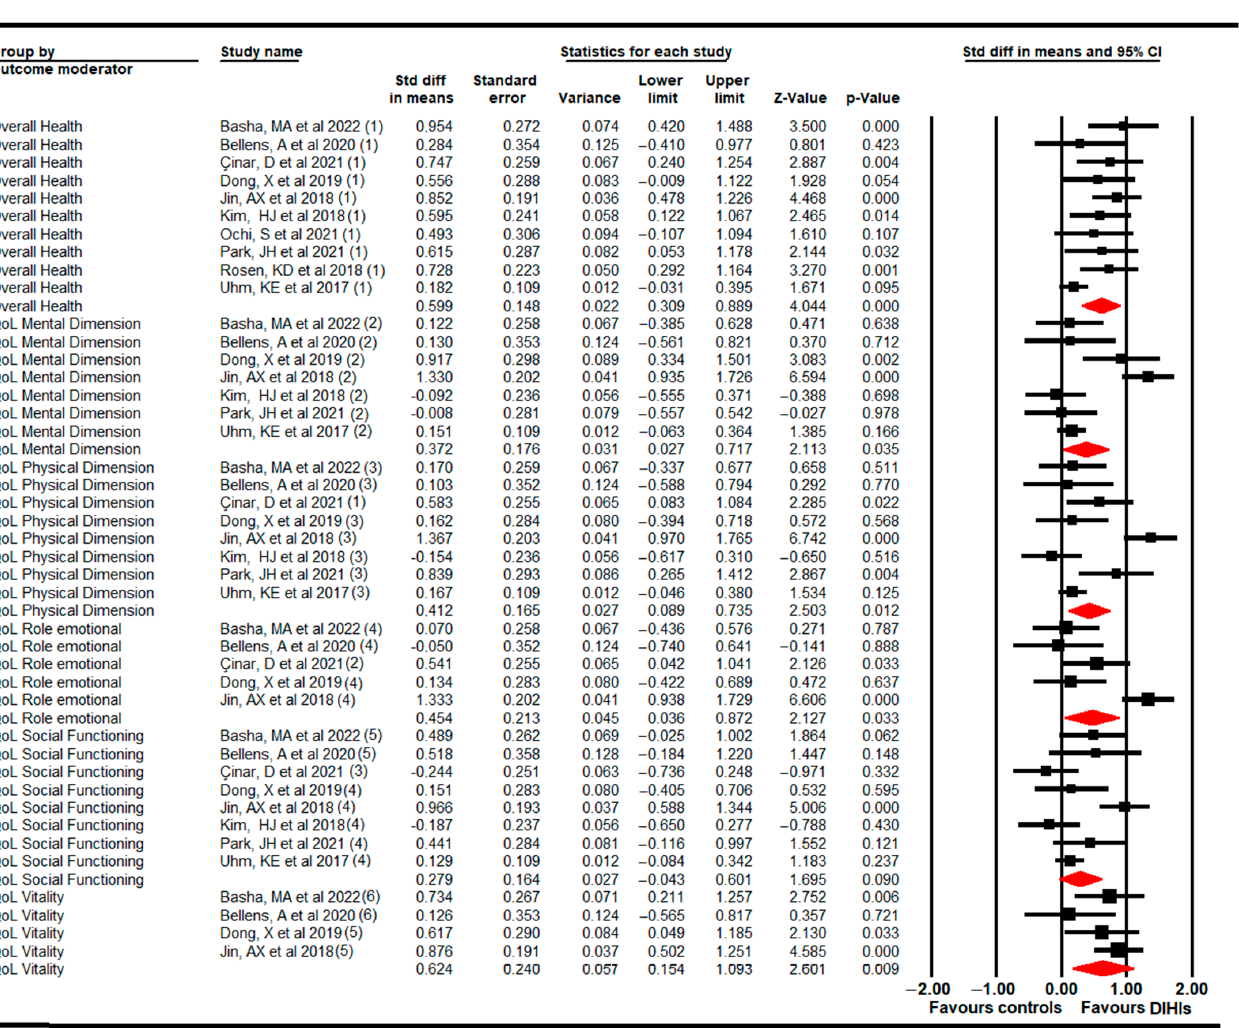
Figure 6. Forest plot of the effect of digital and interactive health interventions on different dimen- sions of quality of life